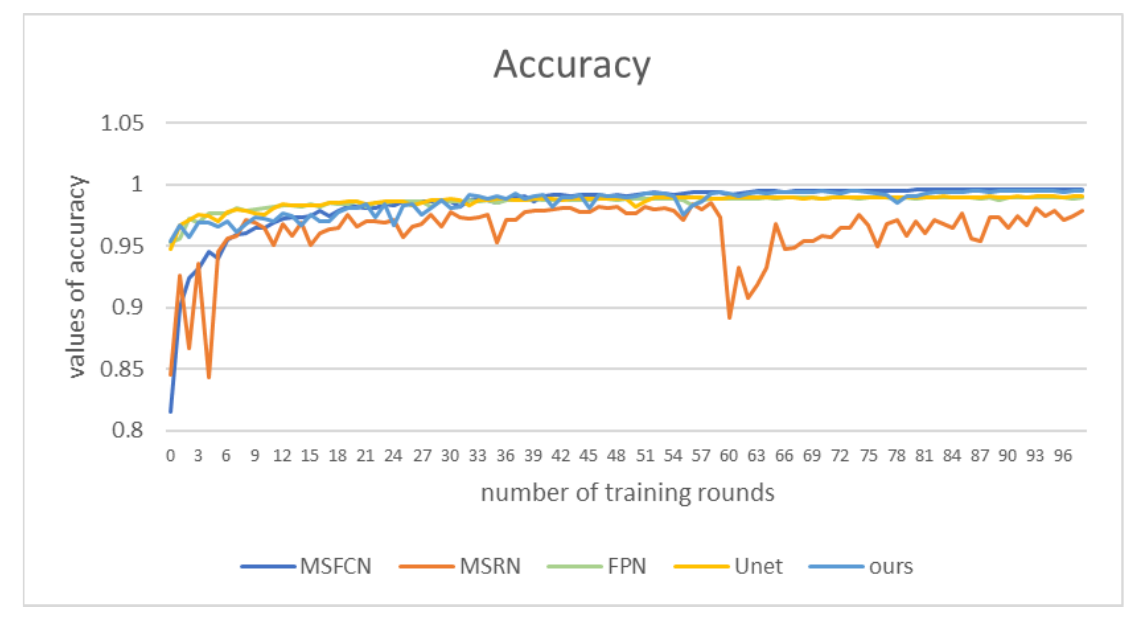
Figure 13. Accuracy values of different models under corresponding epochs.